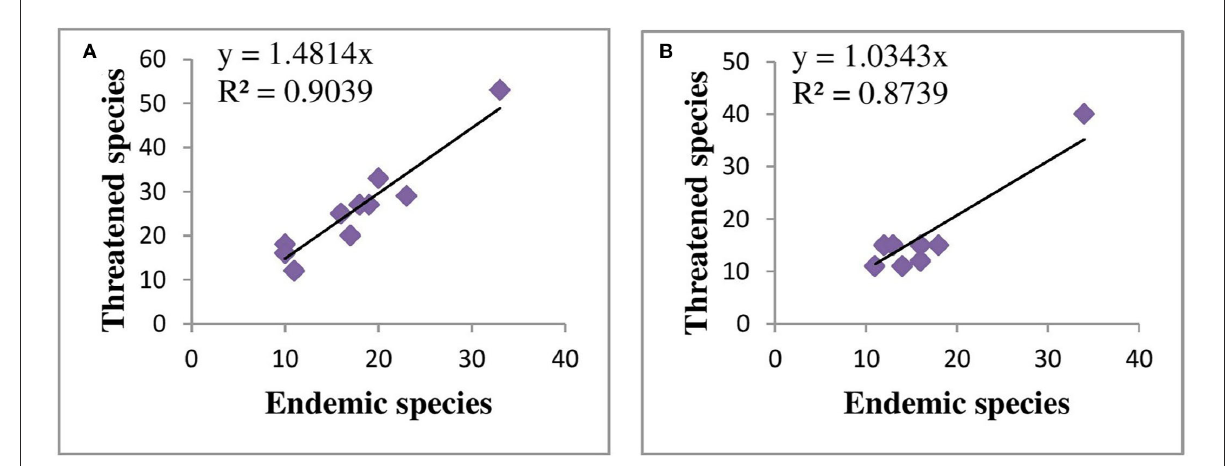
FIGURE8 Correlation of endemic species and threatened species (A) forest zone (B) alpine